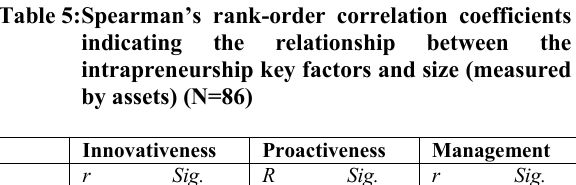
Table 5: Spearman’s rank-order correlation coefficients indicating